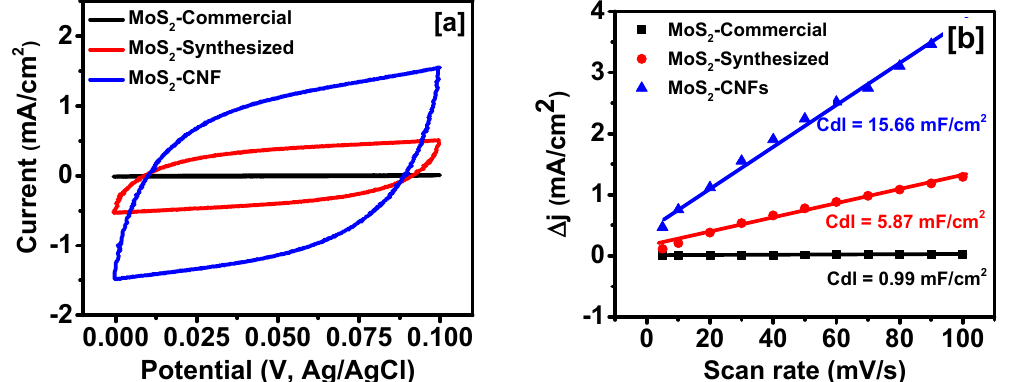
Figure 5. ( a ) Cyclic voltammogram (CV) curves of all samples at 50 mV/s; and ( b ) scan rate dependence of the current densities of all the samples at 0.05 V vs. Ag/AgCl.